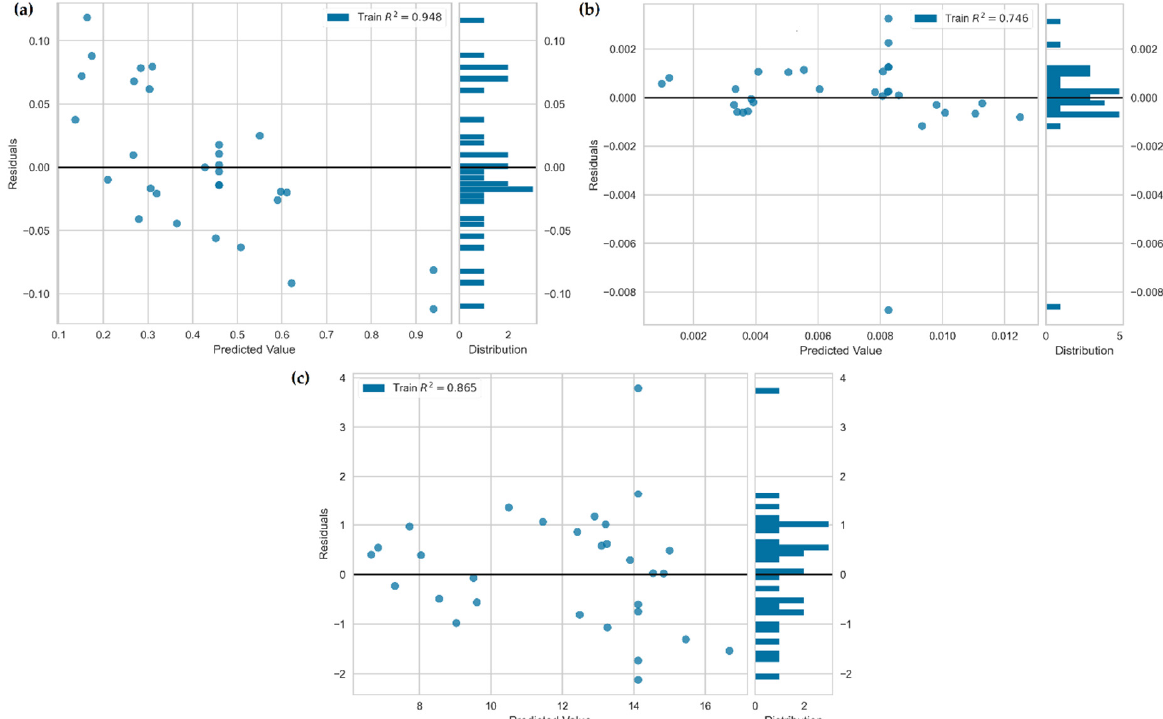
Figure 5. Residuals versus random forest regression predicted ( a ) MRR ( b ) EWR ( c ) SR.